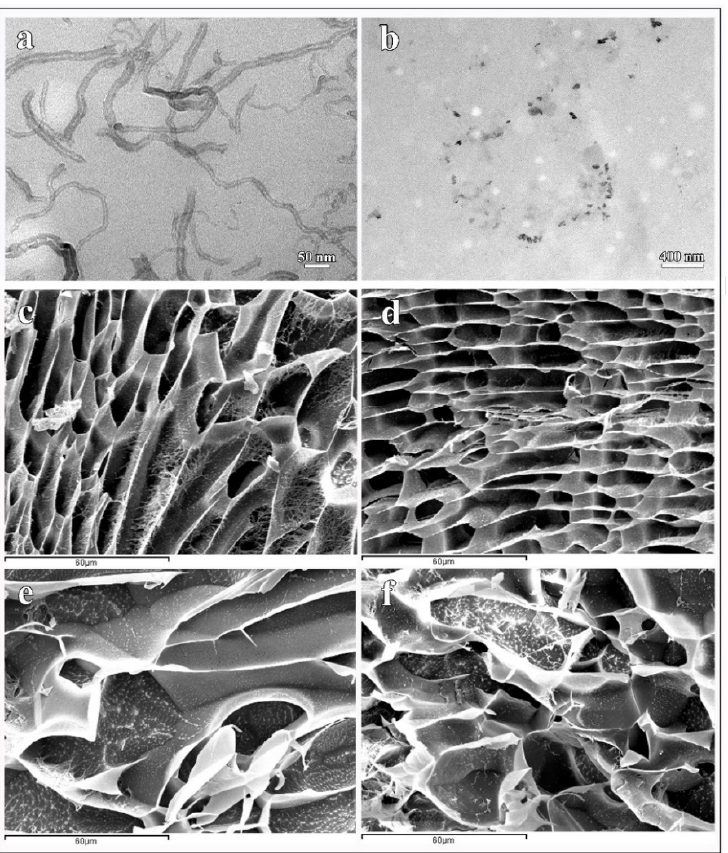
Figure 4. Transmission electron microscopy (TEM) captures of carbon nanofibers (CNFs) ( a ) and ultrathin sections of calcium-cross-linked alginate with CNFs at 1% w/w ratio ( b ); cryo-scanning electron microscopy (cryoSEM) of calcium-crosslinked alginate films, neat ( c , e ) and with CNFs ( d , f ), hydrated at 26 ± 0.5 ◦ C and 37 ± 0.5 ◦ C for 1 day, respectively. Reprinted with permission from Elsevier